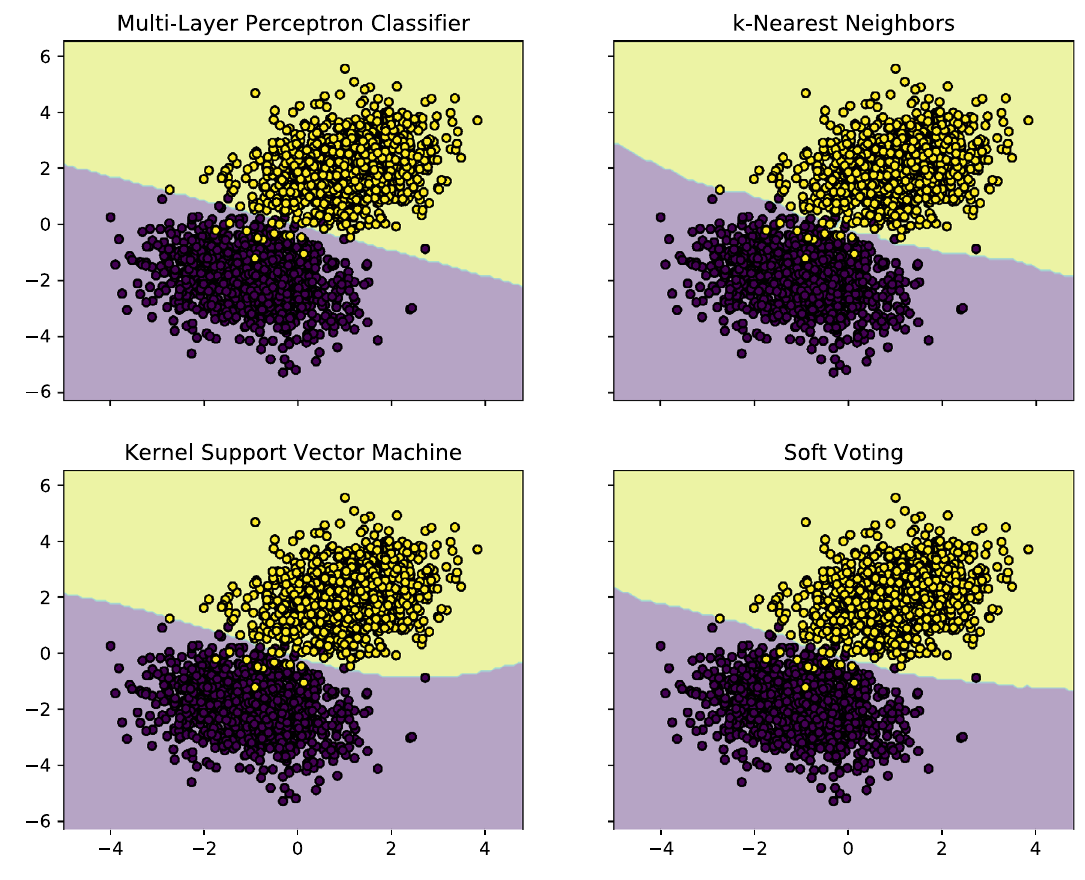
Figure 7. The results of different classification algorithms correspond to the whole two-dimensional synthetic dataset. All classification algorithms present almost the same accuracy for this special binary classification problem. Although there is no considerable difference between the results corresponding to this problem based on our hybrid classical-quantum model presented in Fig. 6 and the results of classical algorithms shown in this figure, the key point is that our proposed model exploits quantum resources, i.e., entanglement and superposition for dealing with machine learning tasks. Hence, it can perform computation significantly faster than the best classical